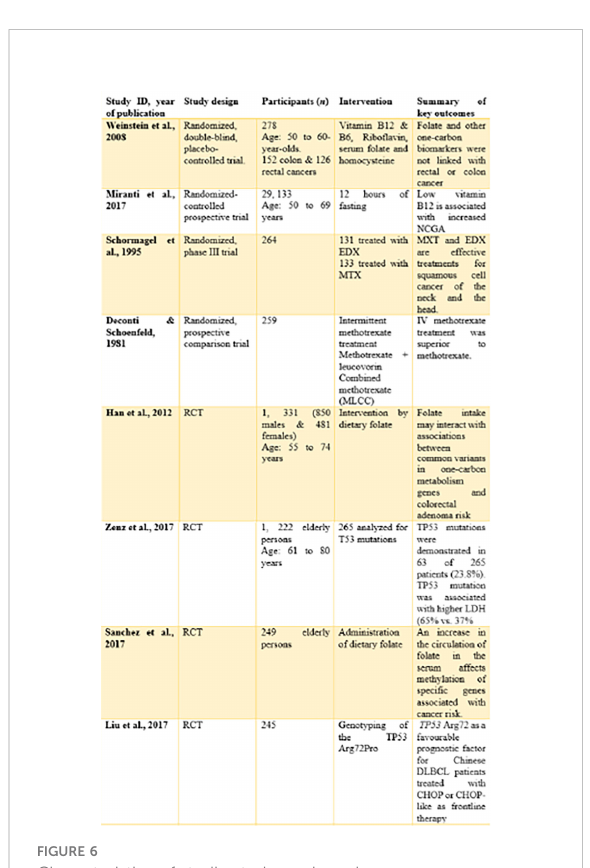
FIGURE 6 Characteristics of studies to be